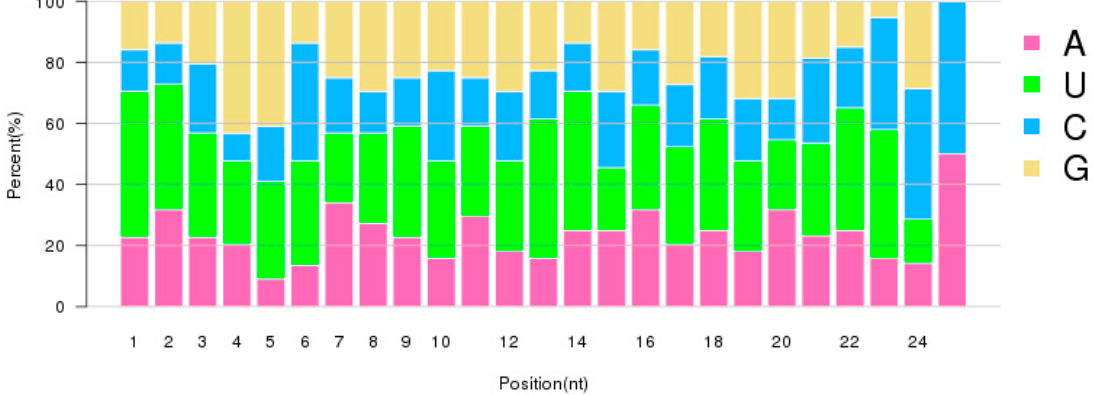
Figure 5. The nucleotide percentage at each position of identified RKN miRNAs.